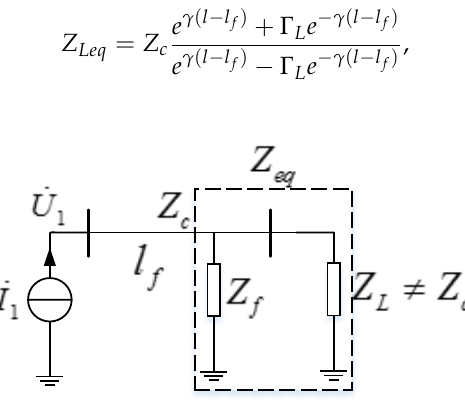
Figure 8. Non-metallic short circuit with mismatching terminal resistor.